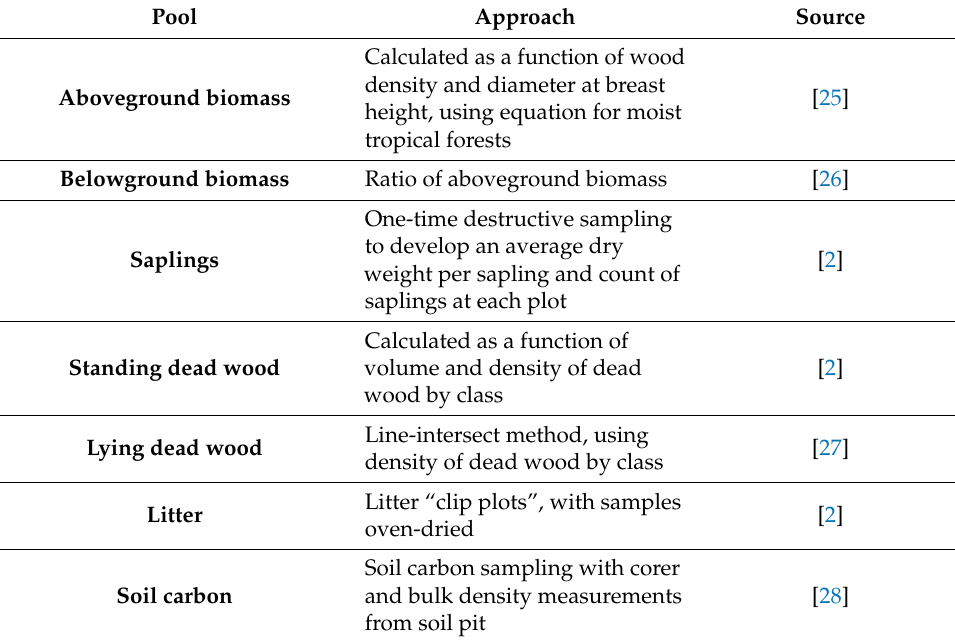
Table 2. Pools included in Guyana’s REDD + Forest Carbon Monitoring System.